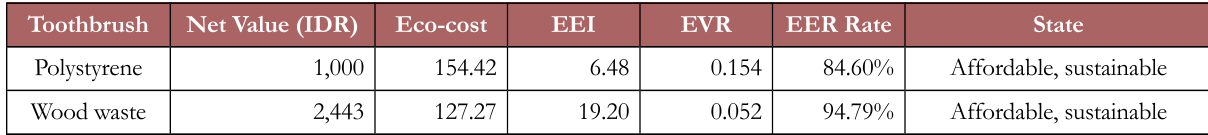
Table 5 The comparison between polystyrene and wood waste